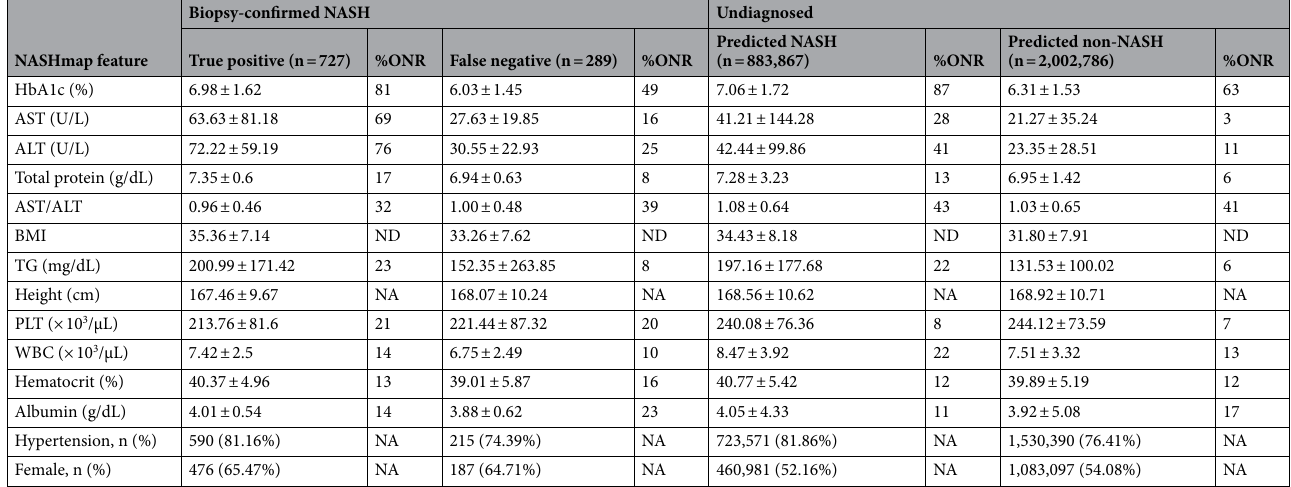
population. In the subcohort of undiagnosed patients with T2DM, 38% (585,272 out of 1,532,744) were predicted as NASH, which is a slightly higher percentage than in the overall population of undiagnosed patients (Table 6). Among the T2DM cohort, there were few clinical differences between predicted NASH and biopsy-confirmed NASH patients. Among NASHmap predicted patients, 51% were female as compared to 66% of biopsy-confirmed NASH patients. Fewer values outside of normal range were found for AST and ALT in NASH predicted patients NASH patients (43%) than in biopsy-confirmed NASH patients (37%).